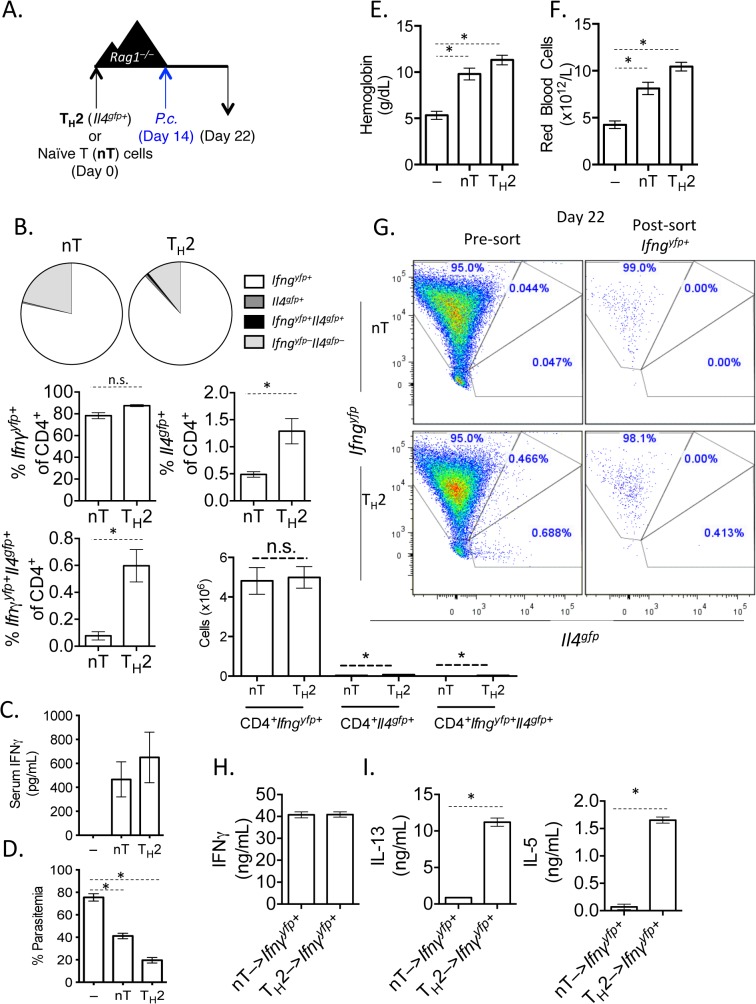

In vitro Th2 cells produce IFNγ and protect Rag1
–/–mice during Plasmodium infection.A). Experimental set-up: 2-week in vitro polarized Th2 cells were FACS sorted as CD4+
Il4
gfp+
Ifng
yfp–
Il17a
FP635– and transferred i.v. to Rag1
–/–mice. As a control, a group of Rag1
–/–mice received naïve CD4+ T cells. A second control group received no T cells. Recipient mice were infected with 105
P. chabaudi i.p. on day 14 post-transfer and harvested at day 8 post-infection. B). Percent and total number of CD4+
Il4
gfp+ and Ifng
yfp+ cells in the spleen, as determined by FACS. C). Serum IFNγ levels determined by ELISA. D). Percent parasitemia was determined by blinded counting of Giemsa-stained blood smears. E and F). Hemoglobin and eHred blood cell counts were measured in peripheral blood by Vetscan. Data is representative of at least 3 independent experiments, with 3–5 mice per group. G). Converted CD4+TCRβ+
Ifng
yfp+
Il4
gfp–
Il17a
FP635– cells were sorted from pooled spleens of 3 recipient Rag1
–/–mice at day 8 post-P. chabaudi infection. H). Sorted Ifng
yfp+ cells were cultured in vitro in Th2 conditions for 5 days. ELISAs for IFNγ (H), IL-5 and IL-13 (I) were run on cell supernatants. Error bars represent technical replicates. Data are representative of 3 independent experiments. * denotes P<0.05.